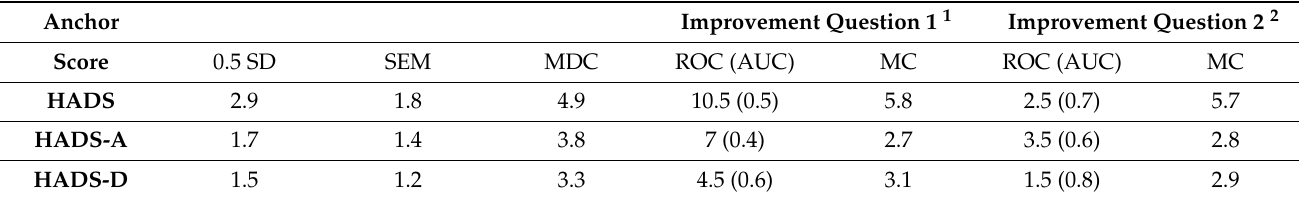
Table 1. Minimum clinically important difference (MCIDs) of the Hospital Anxiety and Depression Scale (HADS), anxiety (HADS-A), and depression